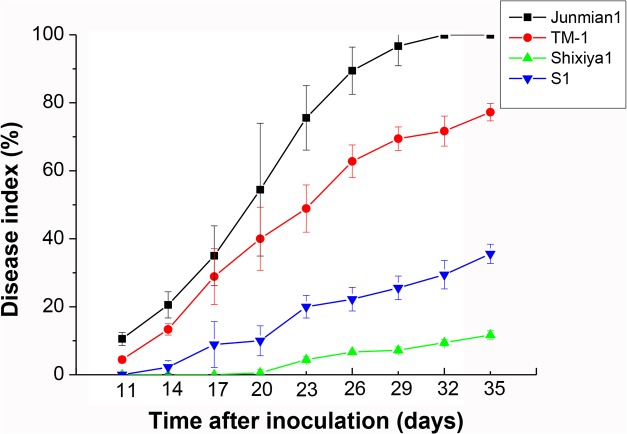
Rate of disease index during 35 days infected by Verticillium dahliae isolate V991.The experiments were repeated in three replicates. The error bars were calculated based on three biological replicates using standard deviation.